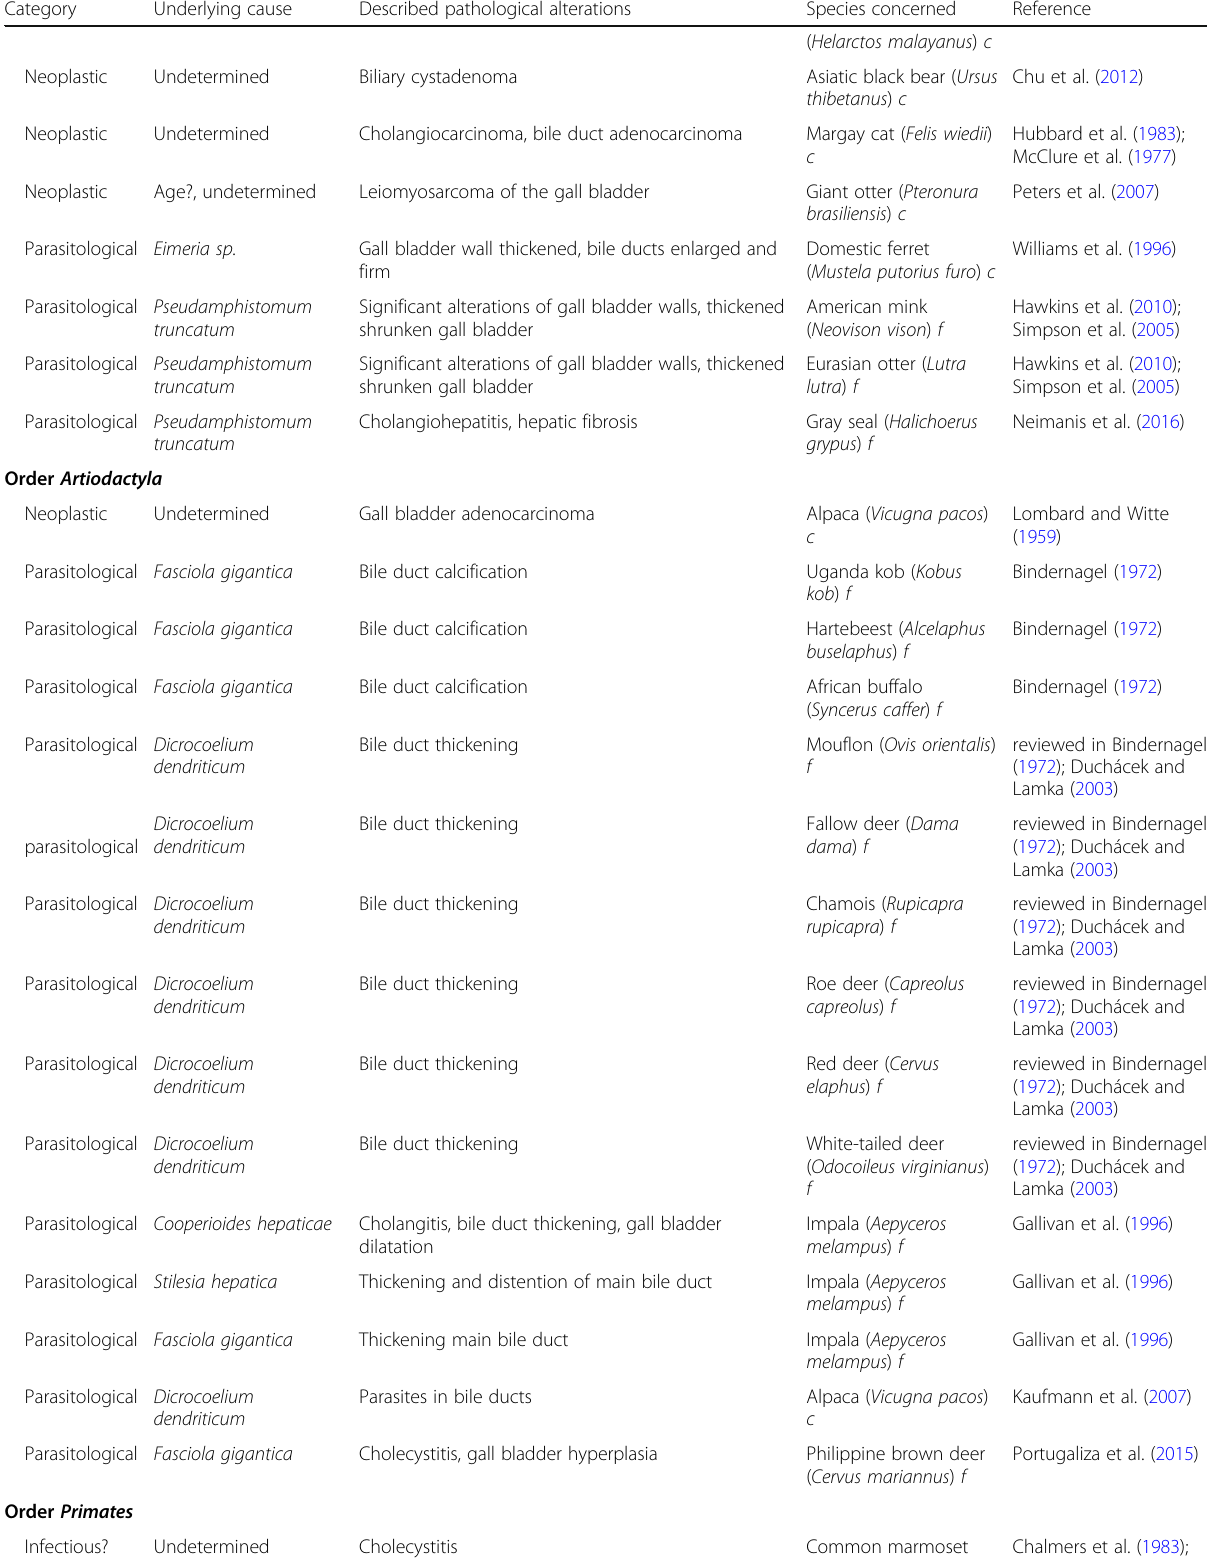
Table 1 Reported pathologies of the extrahepatic biliary tract in mammalian exotic pets and wildlife species (Continued)